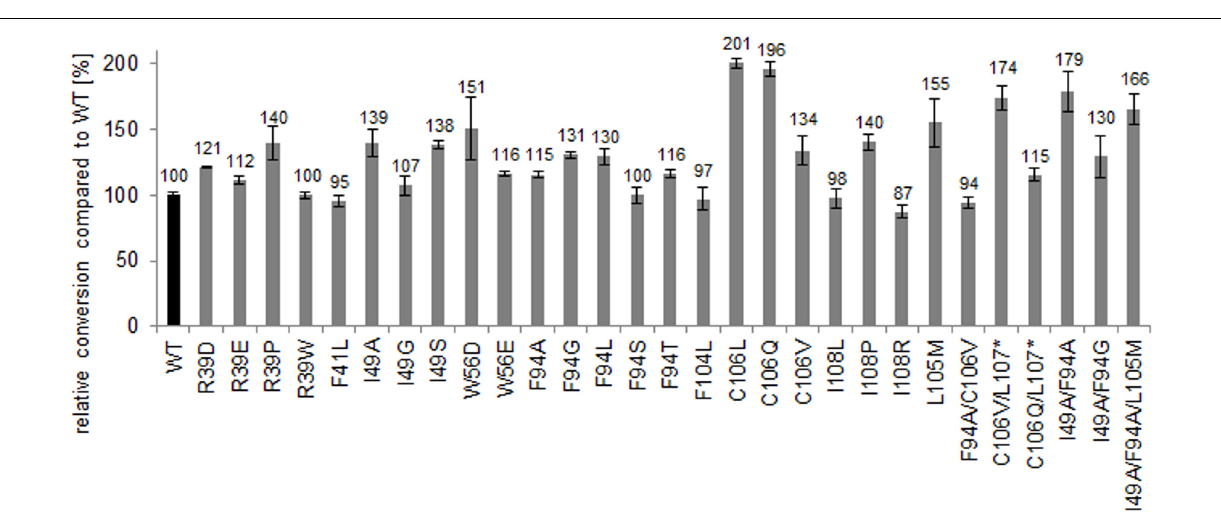
FIGURE 6 | Relative C = C cleavage activity (conversion %) on α -methylstyrene (based on acetophenone formation) of heat-purified TM1459 and variants thereof (1 mg/mL). Reaction conditions: 50 mM α -methylstyrene and 150 mM t -BuOOH in 15% ethylacetate in 50 mM NaPi, pH 7.0, 30 ◦ C and 1,000 rpm for 14 h. 100% refers to conversion of TM1459 (30%